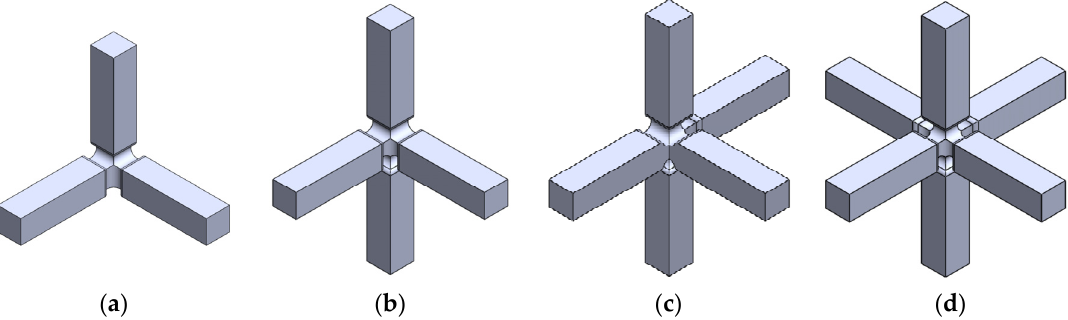
Figure 3. Preliminary design of geometry B: ( a ) CCC loading case; ( b ) CTC loading case; ( c ) CTT loading case; and ( d ) TTT loading case.